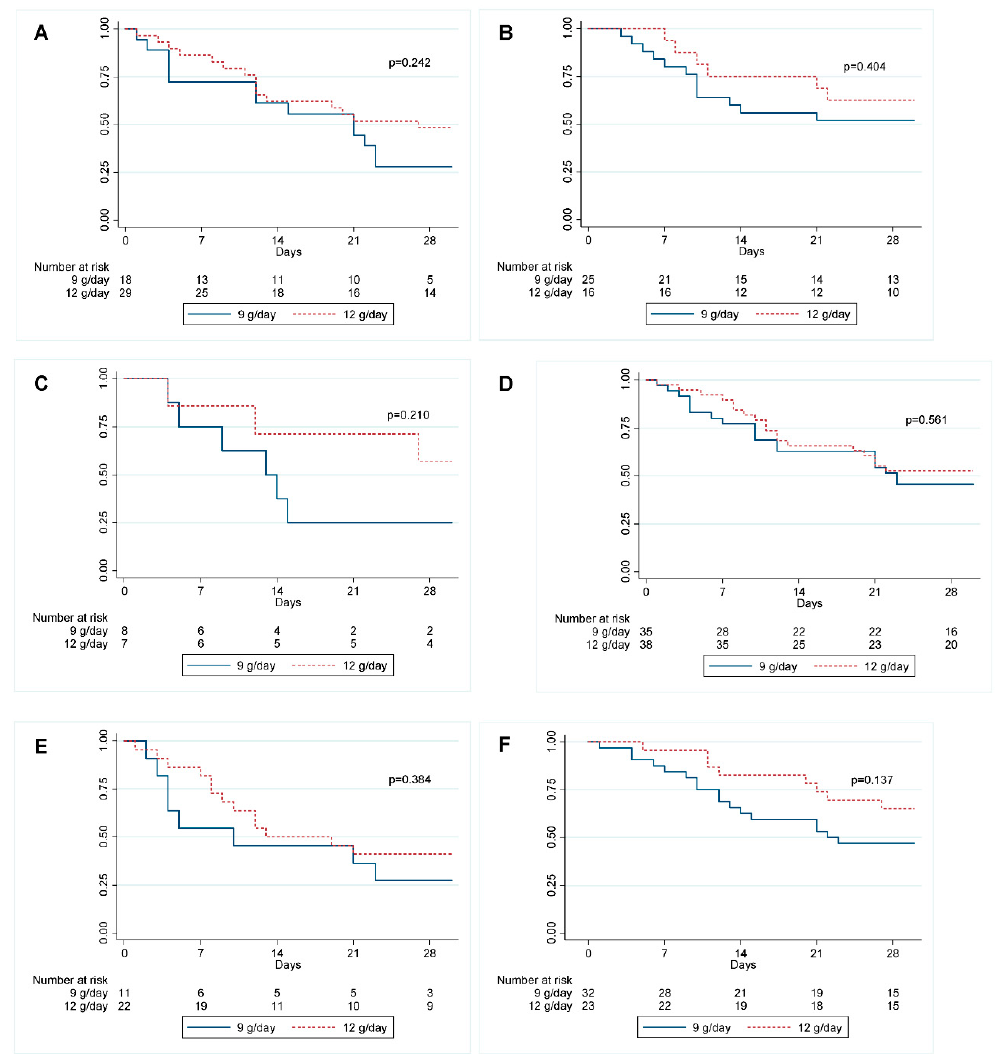
Figure 6. Kaplan-Meier survival curves for 28-day mortality in XDRAB pneumonia patients in relation to sulbactam dose, with subgroup analysis of complications from pneumonia. ( A ) Pneumonia with septic shock, ( B ) pneumonia without septic shock, ( C ) pneumonia with bacteremia, ( D ) pneumonia without bacteremia, ( E ) pneumonia with DIC, ( F ) pneumonia without DIC. Table 5. Univariate and Multivariate Analyses of Risk Factors Associated with 28-day Mortality The length of hospital stay and the number of ventilator days and ICU days were not statistically different between the two groups (Table 3). Microbiological cure at days 7 Using the Cox Regression defined as negative sputum culture was higher in the 12 g/day group (90.5 vs. 58.1%, p = 0.02). The subgroup analysis of patients with sulbactam MIC ≥ 48 mcg/mL showed a higher microbiological cure at day 7 in the 12 g/day group than in the 9 g/day group (93.3% vs. 58.3%, p = 0.03), but no statistically significant difference was found for patients with sulbactam MIC < 48 mcg/mL (86.4% vs. 70%, p = 0.2). Adverse events after treatment were not significantly different. (Table 4).